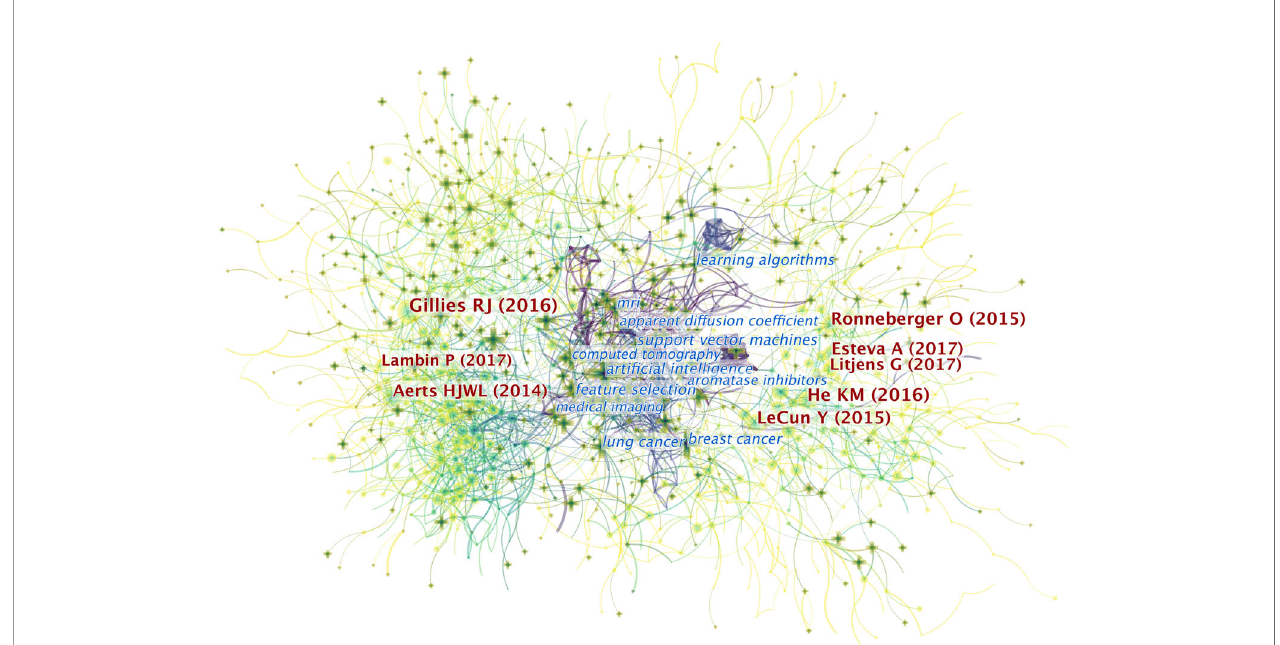
FIGURE 5 | The mixed science map consists of the most cited noun phrases in publications and co-cited references in this fi eld. By doing so, we illustrate the most co-cited references and the noun phrases in this fi eld and uncover the relationship between them. There are two types of shapes in this picture. Each cross symbolizes a noun phrase, and each node represents a piece of co-cited references. There are links between the crosses and the circles. The links between two circles or noun phrases indicate there are some relationships between two pieces of articles or two phrases since they can be cited together. Also, the links between circles and crosses indicate that a piece of paper can be cited with certain noun phrases. Generally, there are three domains of this map. On the right and the left sides lay the most co-cited articles in the fi eld. The ones on the left are mainly related to the de fi nition and application of radiomics while the references on the right are mostly related to the AI algorithms involved in this fi eld. In the middle are the most-cited noun phrases in the articles in this fi eld. As indicated in the picture, the publications that contain these phrases are the bridges to relate publications from both sides. It illustrated that the most-cited articles from both sides may focus on conducting researches related to the noun phrases in the middle.